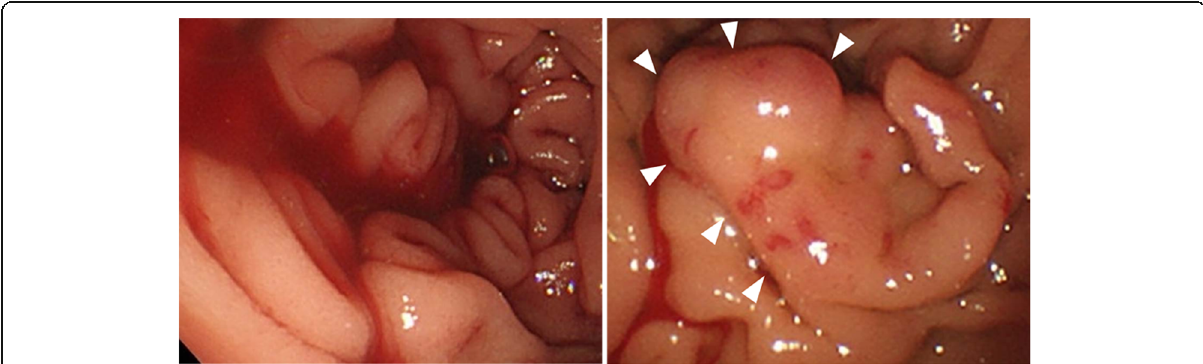
Fig. 3 Gastrointestinal endoscopy showed oozing from the swollen vascular hyperplasia (arrow heads) in the duodenum